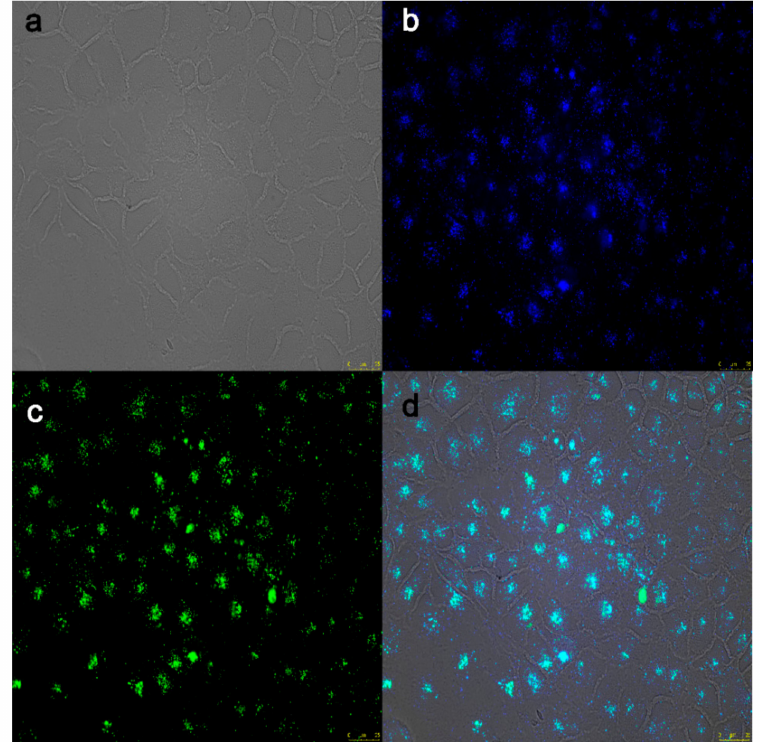
Figure 7. ( a ) Bright-field and ( a – c ) fluorescent images of Hela cells incubated with Pdots-PPF. ( d ) merged image of ( a ), ( b ) and ( c ). Scale bar represents 25 µ